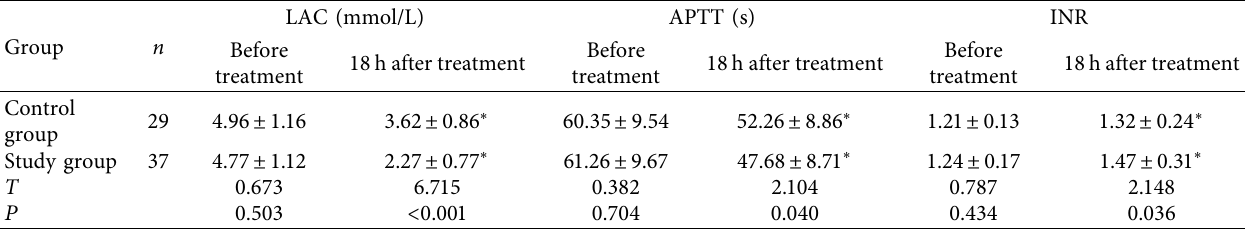
Table 3: Comparison of LAC, APTT, and INR levels between the control group and the study group ( x ± s ). LAC (mmol/L) APTT (s) INR Group n Before